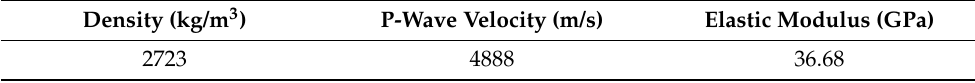
Figure 2. Specimens of granite and experiment system: ( a ) the granite specimens, ( b ) the granite between the incident bar and transmitted bar. Table 1. Mechanical parameters of granite under static load.